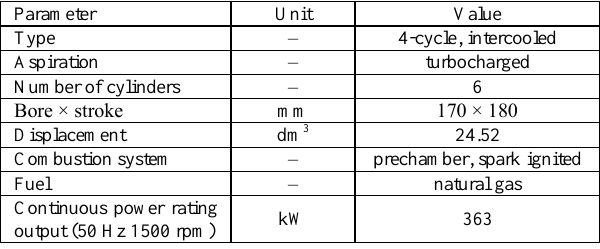
Table 1. Characteristics of the GS16R2-PTK engine [14]